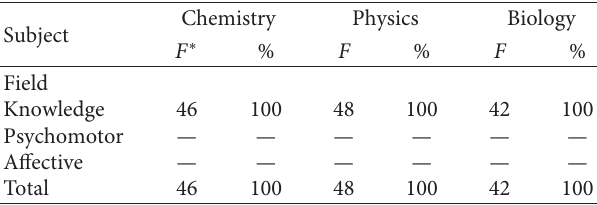
Table 2: Final examinations’ question distribution for chemistry, physics, and biology based on course objectives.